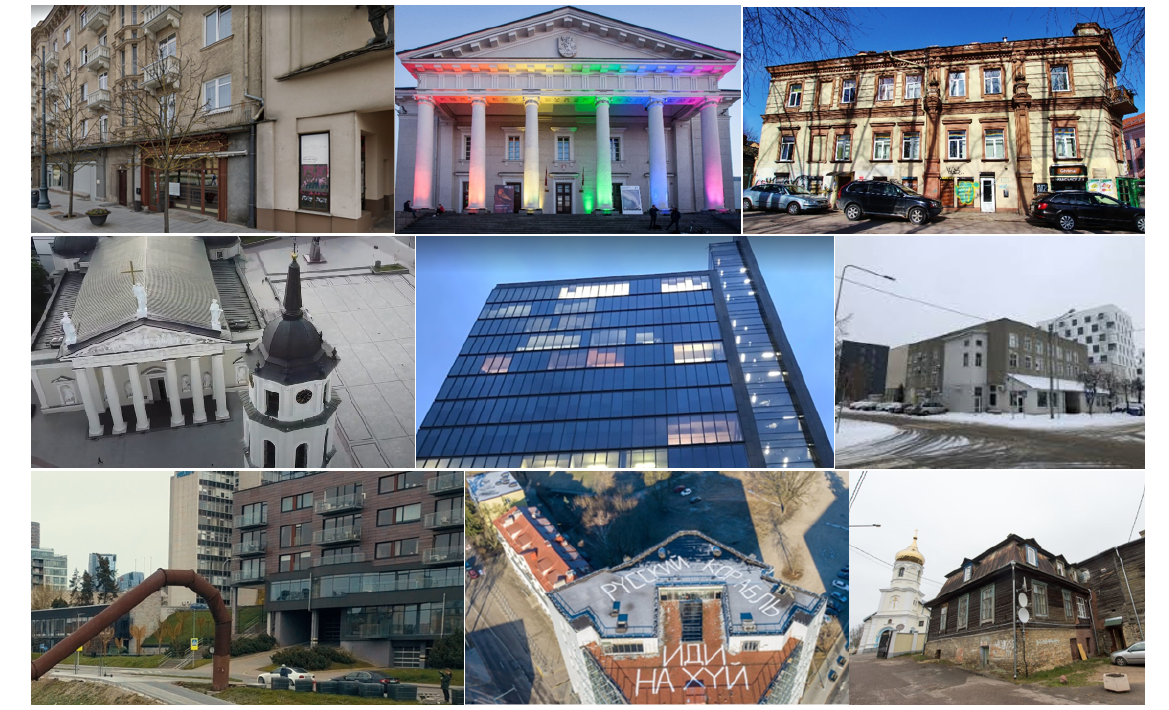
Figure 7. Famous Vilnius (Wilno) buildings used in the